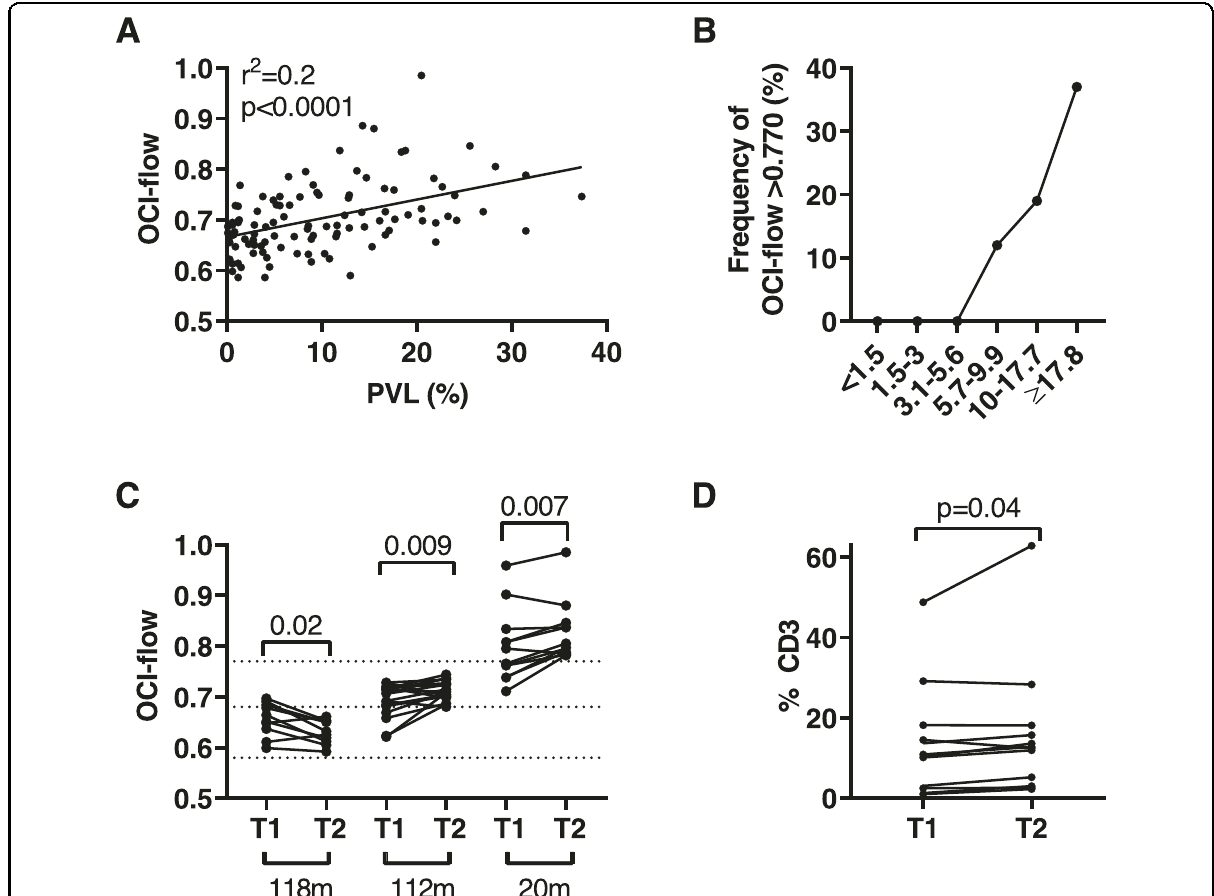
Fig. 2 Relationship of proviral load with OCI- fl ow. a Proviral load and OCI- fl ow score of subjects in the screening cohort ( n = 106). A simple linear regression line is plotted. b Frequency of subjects with an OCI- fl ow > 0.770. PVL is binned in 0.25log 10 intervals. The number of subjects in each proviral load bin was: <1.5% ( n = 21), 1.5 – 3 ( n = 8), 3.1 – 5.6 ( n = 15), 5.7 – 9.9 ( n = 17), 10 – 17.7 ( n = 26) and ≥ 17.8 ( n = 19). c Temporal changes in OCI- fl ow. Subjects who were analysed longitudinally were binned by the OCI- fl ow score of the most recent sample: <0.680 ( n = 10), 0.680 – 0.770 ( n = 18) and >0.770 ( n = 12) and tested for differences in OCI- fl ow between timepoint 1 (earliest) and time point 2 (latest). Statistical analysis: Wilcoxon test, two-tailed. d The frequency of ATL-like clones over time ( n = 12, median interval = 20 months) was analysed using the Wilcoxon test,